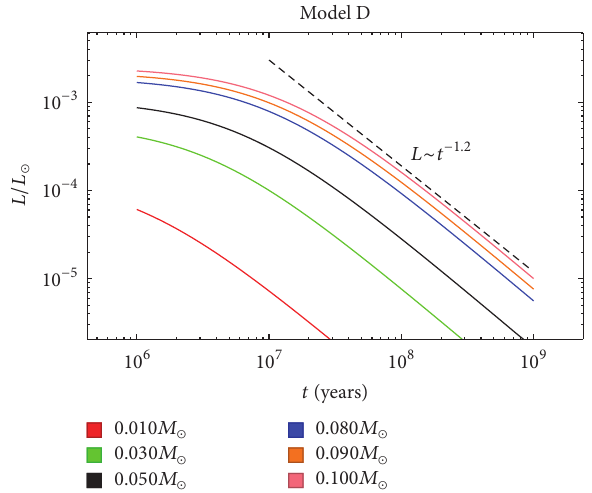
Figure 2: The variation of 𝐿/𝐿 ⊙ over time 𝑡 for different masses.